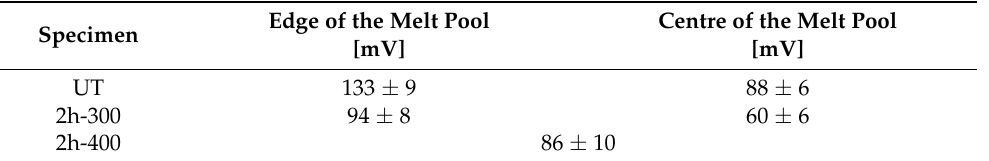
Table 3. Volta potential difference between Si and α -Al phases in AlSi10Mg LPBF samples after different post-heat treatments.